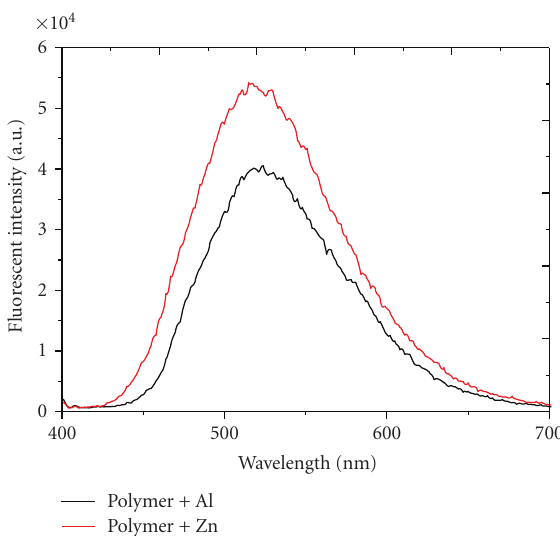
Figure 9: The UV-vis absorption spectra of Alq 3 - and Znq 2 - containing copolymers in CHCl 3 . The concentration of 8-hydrox- yquinoline moieties is 2.0 × 10 − 5 M.